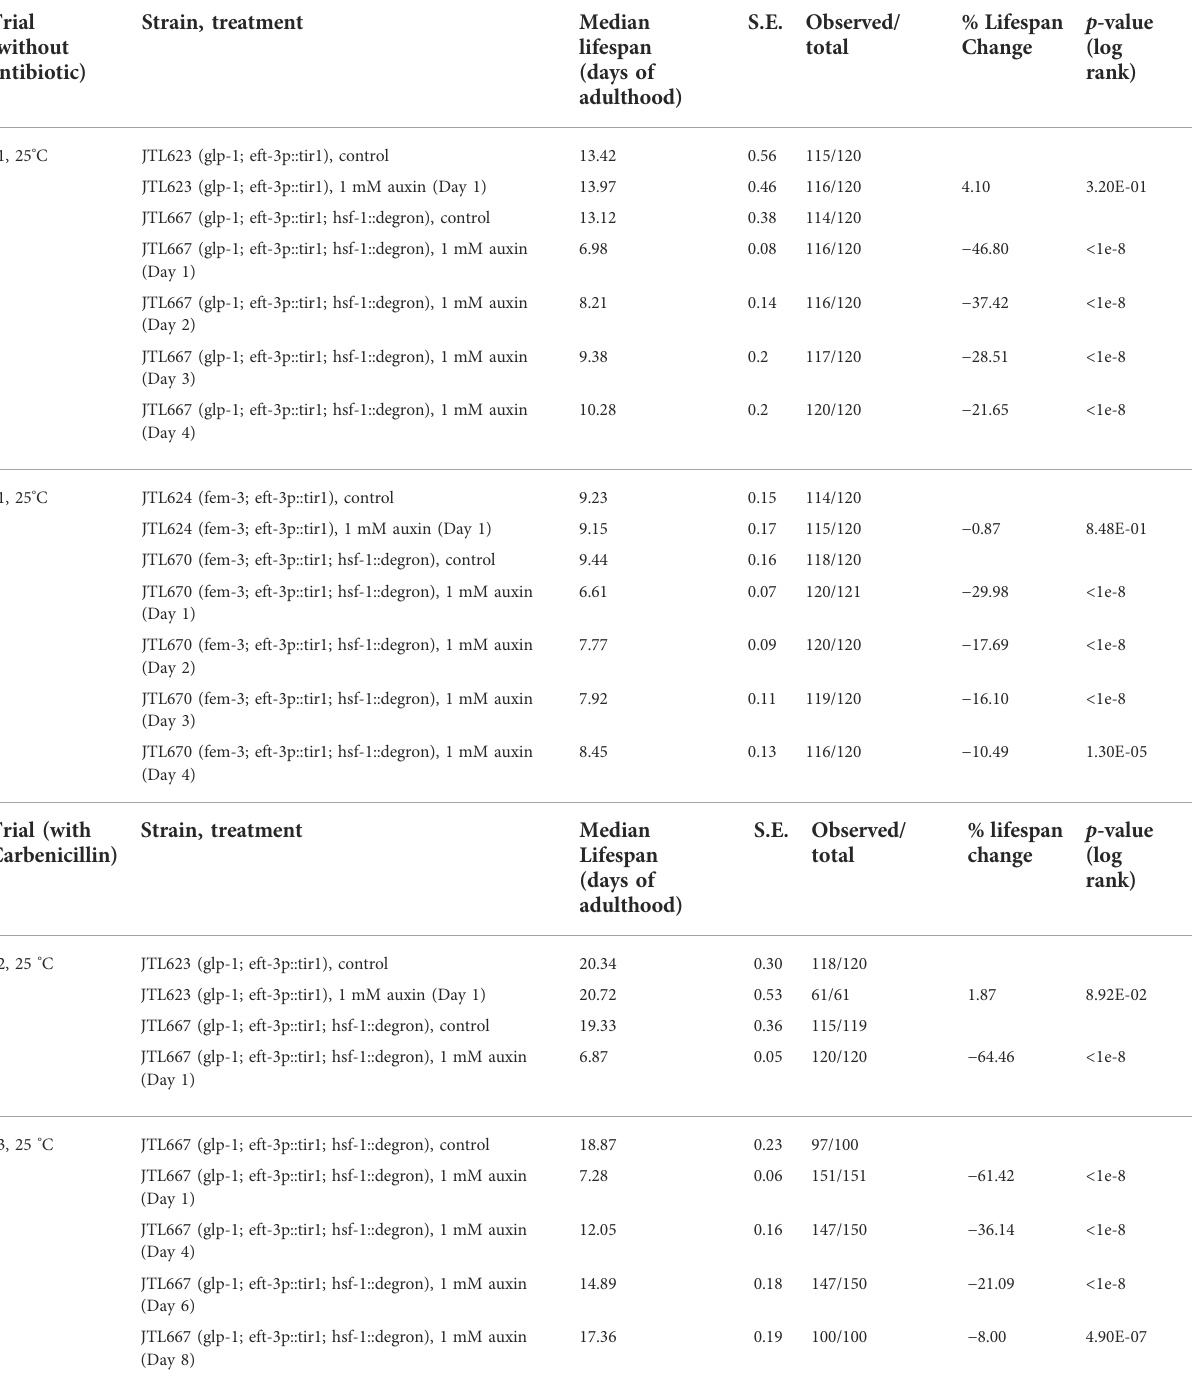
TABLE 2 A correction has been made to the section